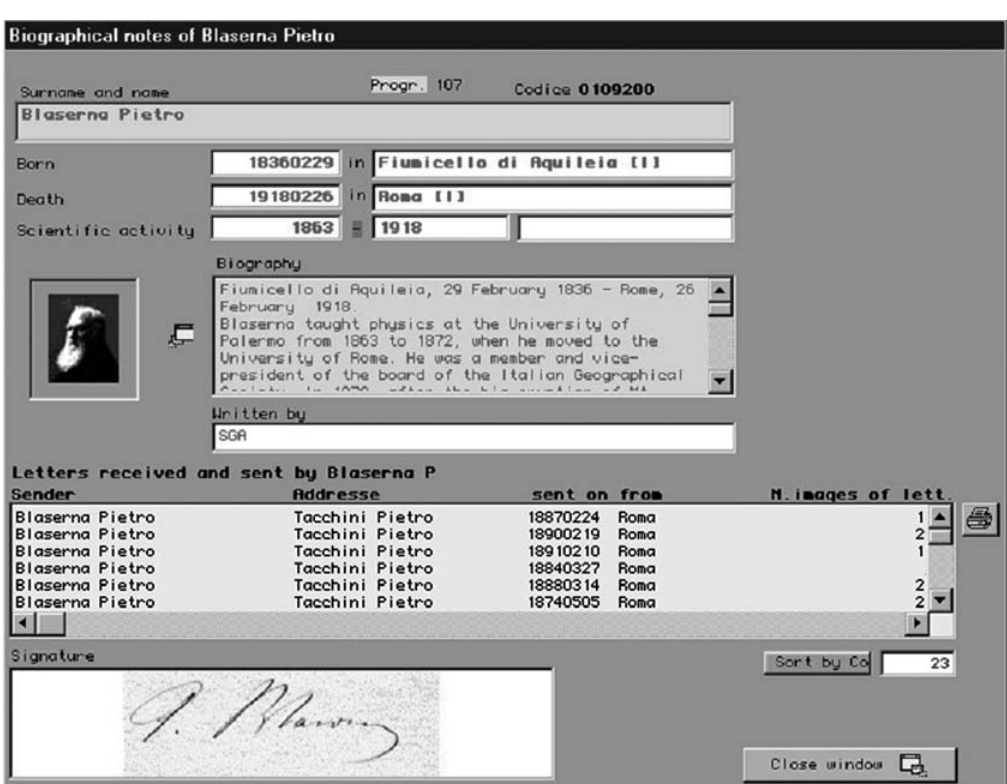
Fig. 8. Scholars and associations file, example of record. Apart from the biographical information, the window reports the list of the letters sent or received by the scholar. Double clicking on the line of interest opens a win- dow with the details of the related letter, also with the chance to open the PDF file of the integral raster repro- duction of the